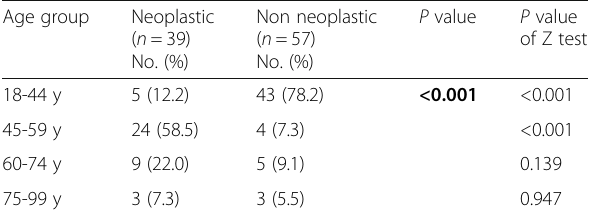
Table 3 The prevalence of neoplastic and non-neoplastic incidental findings in different age groups